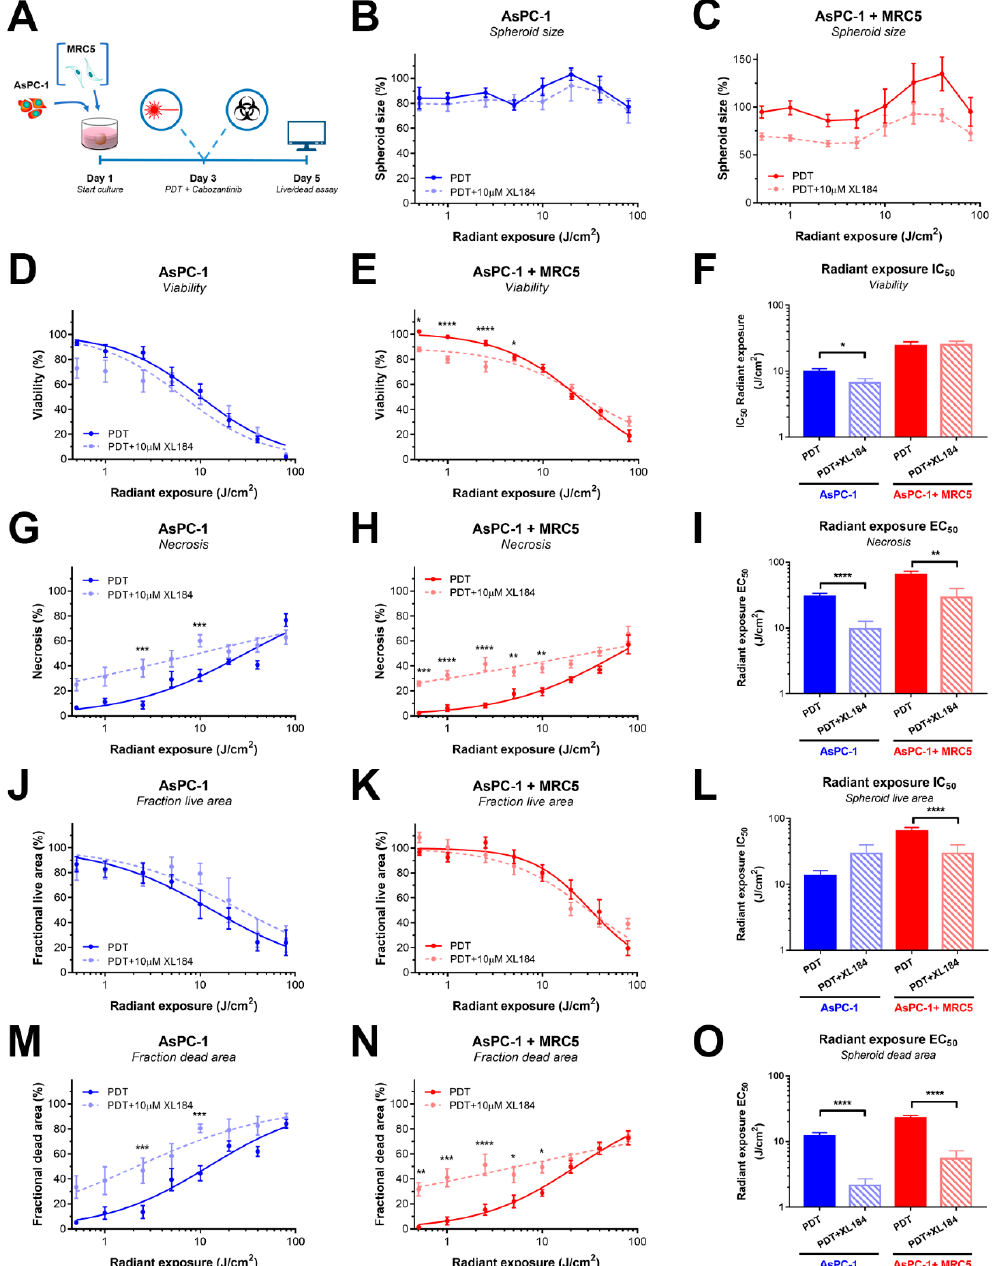
Figure 5. Cabozantinib augments the capacity of PDT to elevate necrosis in AsPC-1 and AsPC-1+MRC5 spheroids. ( A ) Schematic overview of the experimental timeline. ( B,C ) Effect of cabozantinib + PDT on overall AsPC-1 ( B ) and AsPC-1+MRC5 ( C ) spheroid size. ( D–F ) The effect of cabozantinib on the PDT efficacy based on spheroid viability in AsPC-1 (D), AsPC-1+MRC5 spheroids (E), and a statistical comparison of the fitted IC 50 values (F). ( G–I ) The effect of cabozantinib on the PDT efficacy based on spheroid necrosis in AsPC-1 (G), AsPC-1+MRC5 spheroids (H), and a statistical comparison of the fitted EC 50 values (I). ( J–L ) The effect of cabozantinib on the PDT efficacy based on the fractional live area of AsPC-1 (J), and AsPC-1+MRC5 spheroids (K), and a statistical comparison of the fitted IC 50 values (L). ( M–O ) The effect of cabozantinib on the PDT efficacy based on the fractional dead area of AsPC-1 (M), and AsPC-1+MRC5 spheroids (N), and a statistical comparison of the fitted EC 50 values (O). All data are the mean ± SEM from N = 12 from three technical repeats. The error in IC 50 values represents the SD. Statistical significance is indicated as * p < 0.05, ** p < 0.01, *** p < 0.005, or **** p <